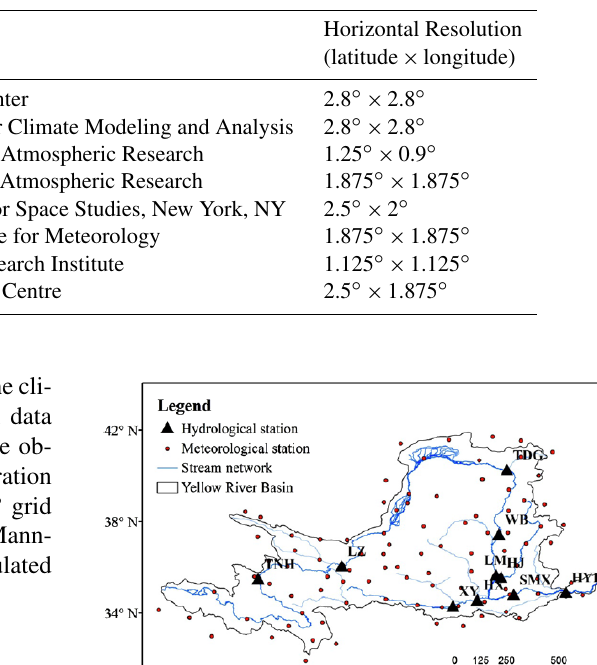
Table 1. The information of eight CMIP5 models.